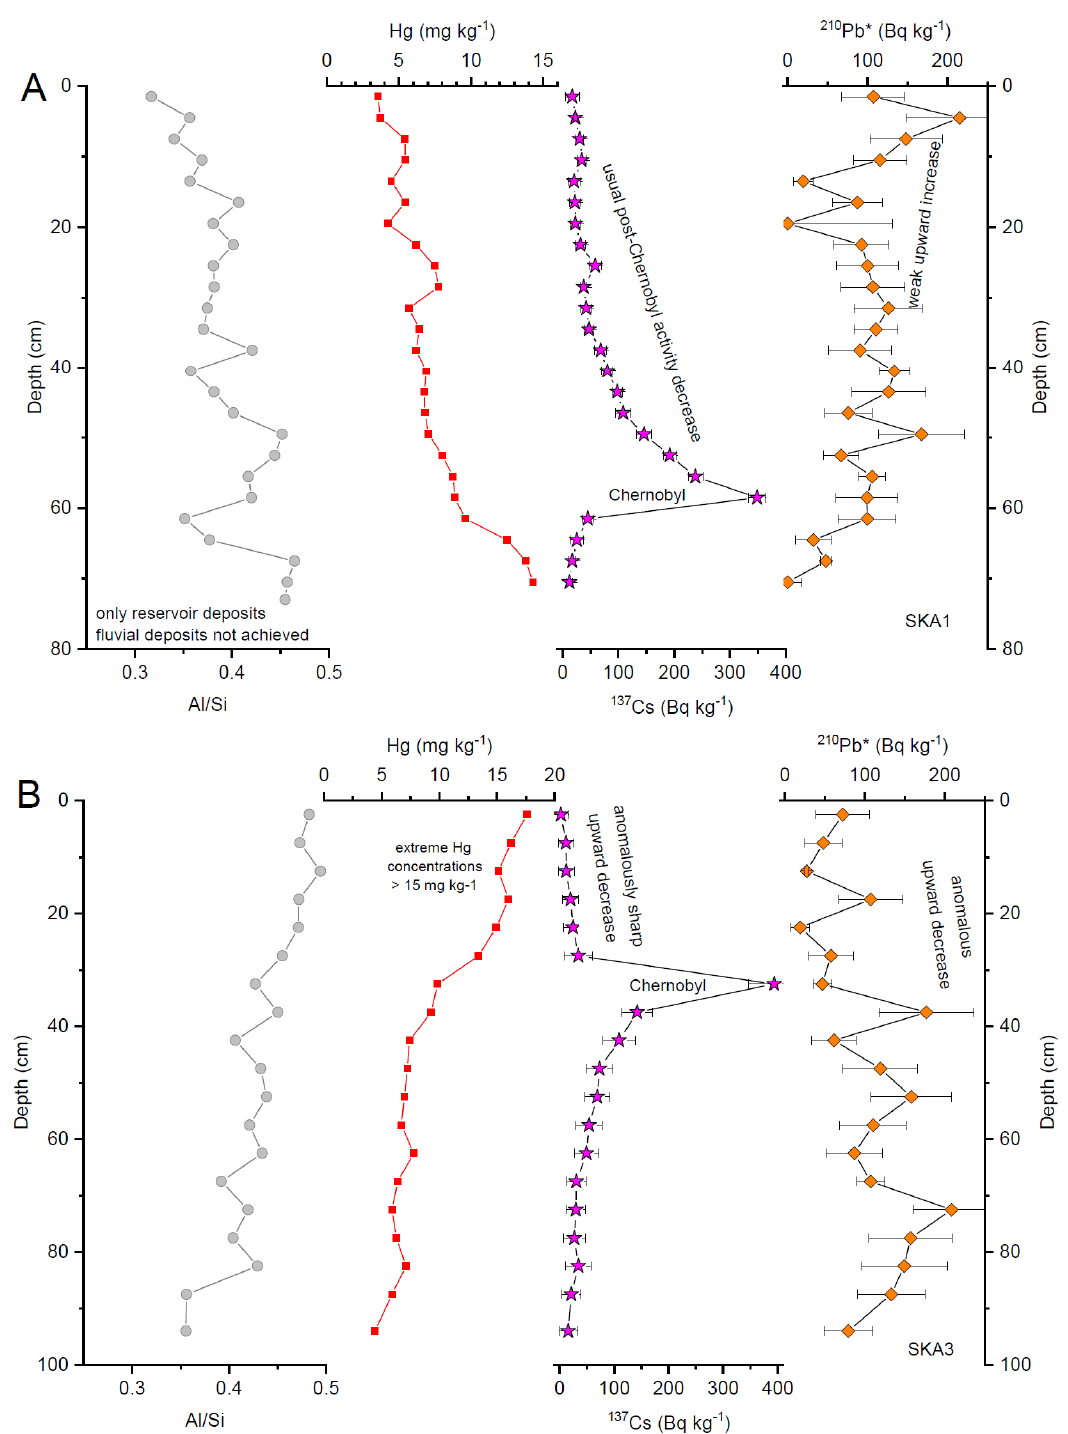
Figure 5. SKA1 ( A ) and SKA3 ( B ) cores from the Skalka Reservoir. Al/Si is proxy of sediment fineness, Chernobyl 137 Cs peak is used as a key stratigraphic marker. Other profiles are shown in Supplementary